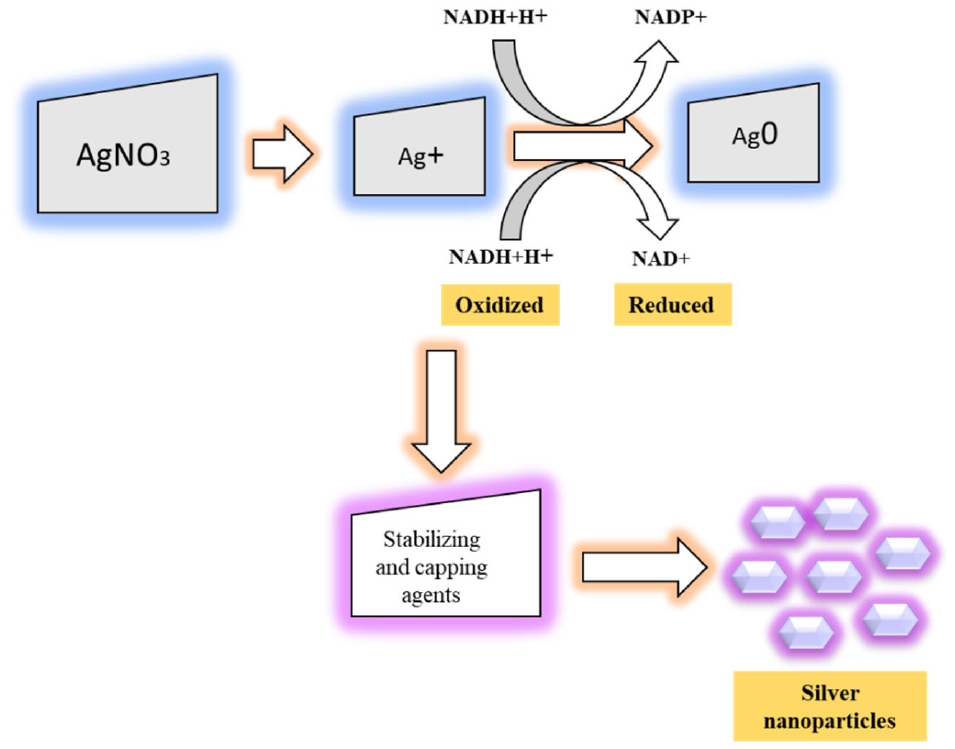
the presence of hydroxyl functional groups in different bioactive compounds in plant and microorganism extracts. However, there is no clear AgNPs synthesis mechanism due to the presence of different biomolecules in different plants. It was reported that the formation of colloidal stable-controlled shape and size of the nanoparticles depends on the surface of the particle and the type of stabilizing agent being used. The stabilization of nanoparticles may occur due to the (1) electrostatic repulsion of particles and (2) generation of steric repulsion by non-ionic surfactants [41]. The size of the NPs could be modified by changing the different physical and chemical parameters such as pH, temperature, and the concentration of reducing agents involved in NPs synthesis [42]. The mechanism of AgNPs formation is represented in Figure 3.